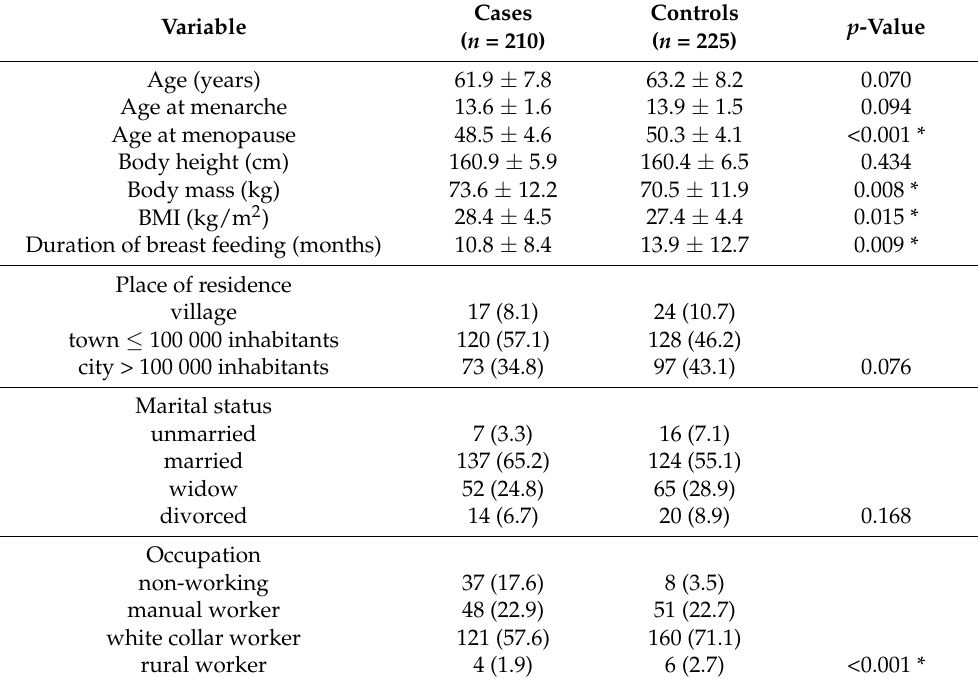
Table 1. Selected characteristics of breast cancer postmenopausal women and the comparison